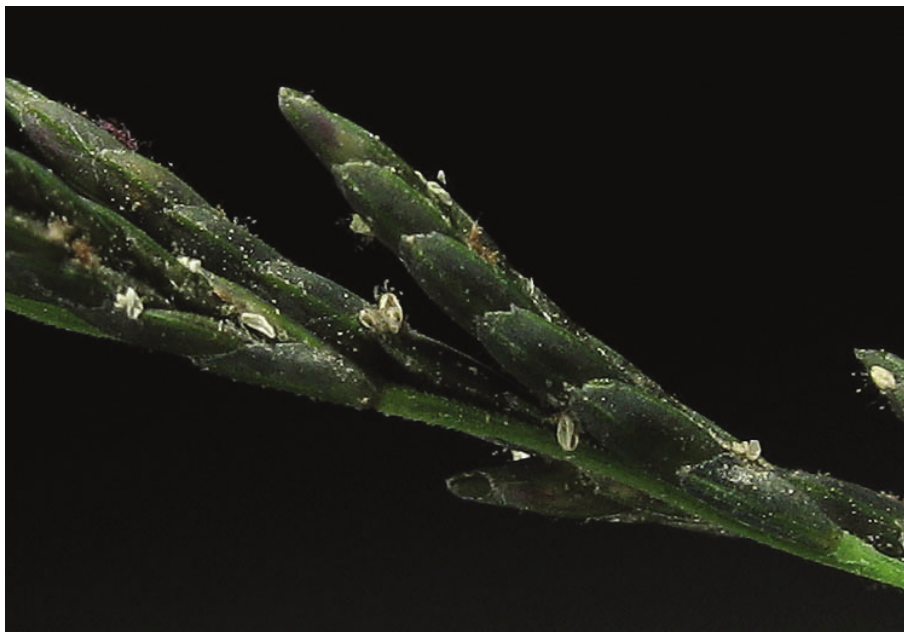
Figure 7. Spikelets of Diplachne fusca subspecies uninervia . The dark olive-green or often plumbeous color of spikelets is common for this subspecies, but rarely occurs in its Neotropical counterpart D. f. subsp. fascicularis . Photo with permission by Anthony Valois, Santa Monica Mountains National Recrea- tion Area, California (no